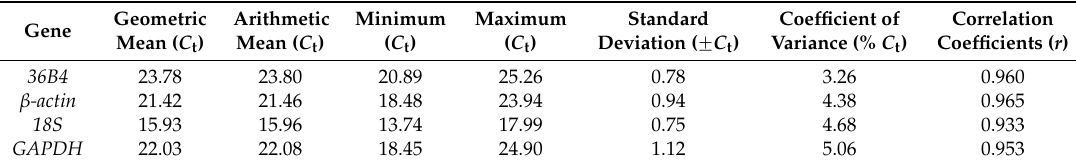
Table 2. Expression stability of four reference gene in brown adipose tissue (BAT) evaluated by BestKeeper ( n = 12).